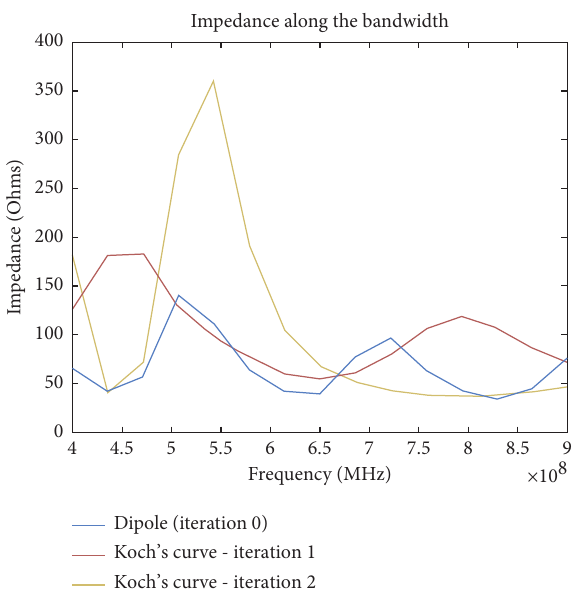
Figure 20: Comparison between dipole and Koch’s curves